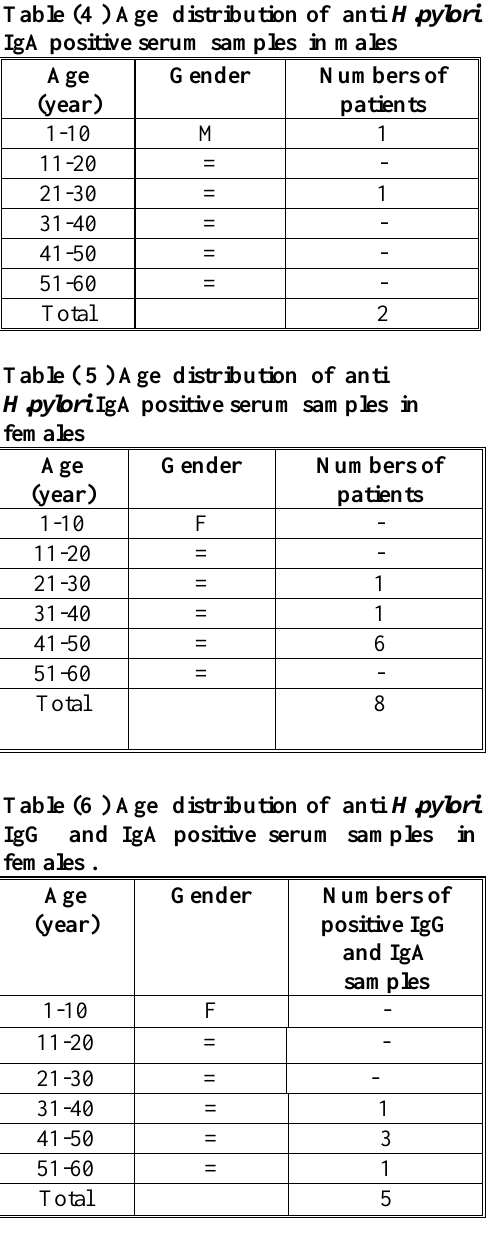
Table (7 )Age distribution of anti H.pylori IgG and IgA positive serum samples in males .